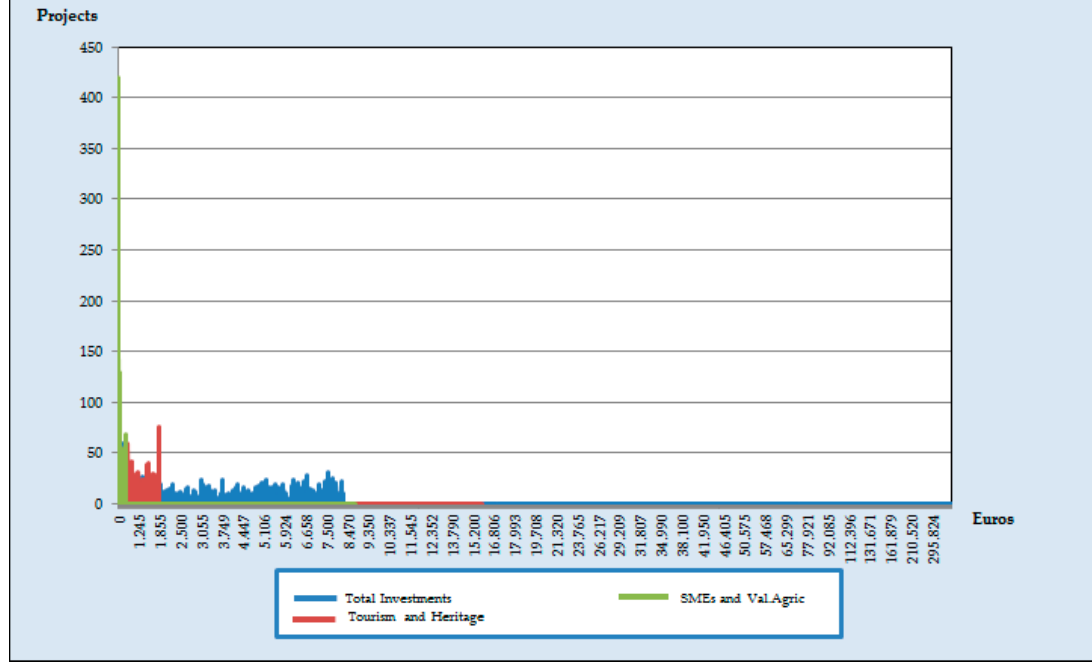
Figure 3. Frequency plot with LEADER Approach’s investments in Extremadura (2000–2013).